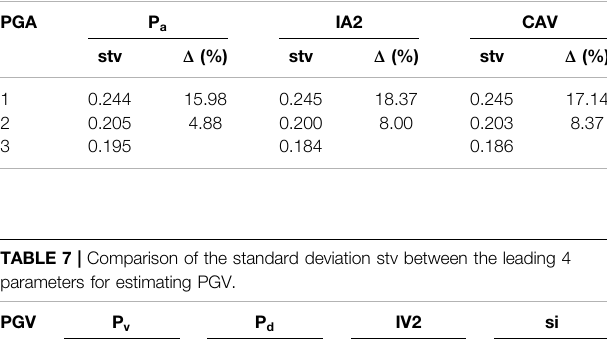
TABLE 6 | Comparison of the standard deviation stv between the leading 3 parameters for estimating PGA.